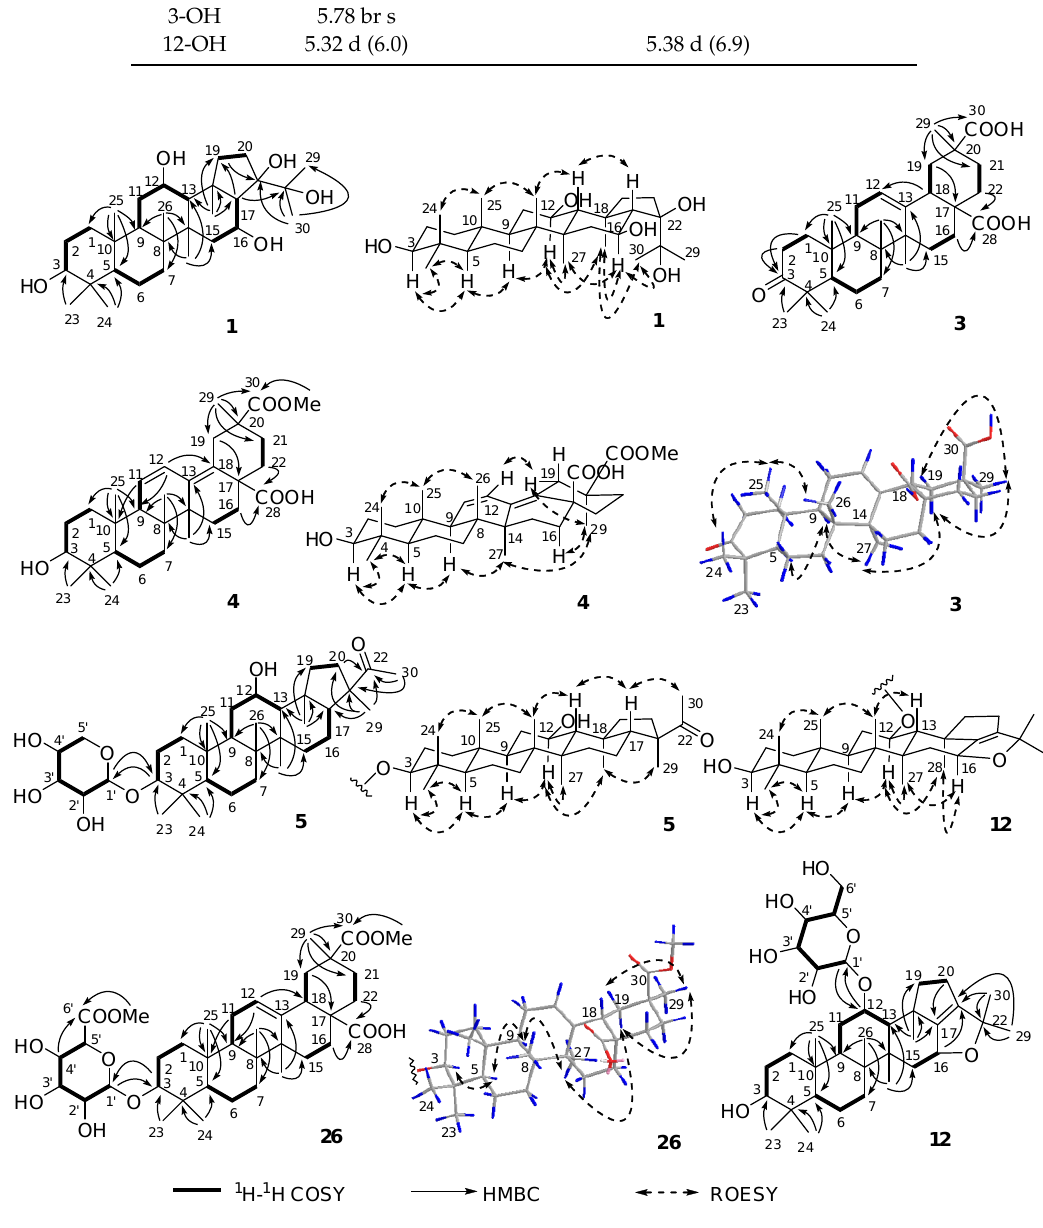
Figure 2. Key 2D-NMR correlations of 1 , 3 – 5 , 12 , and 26 .